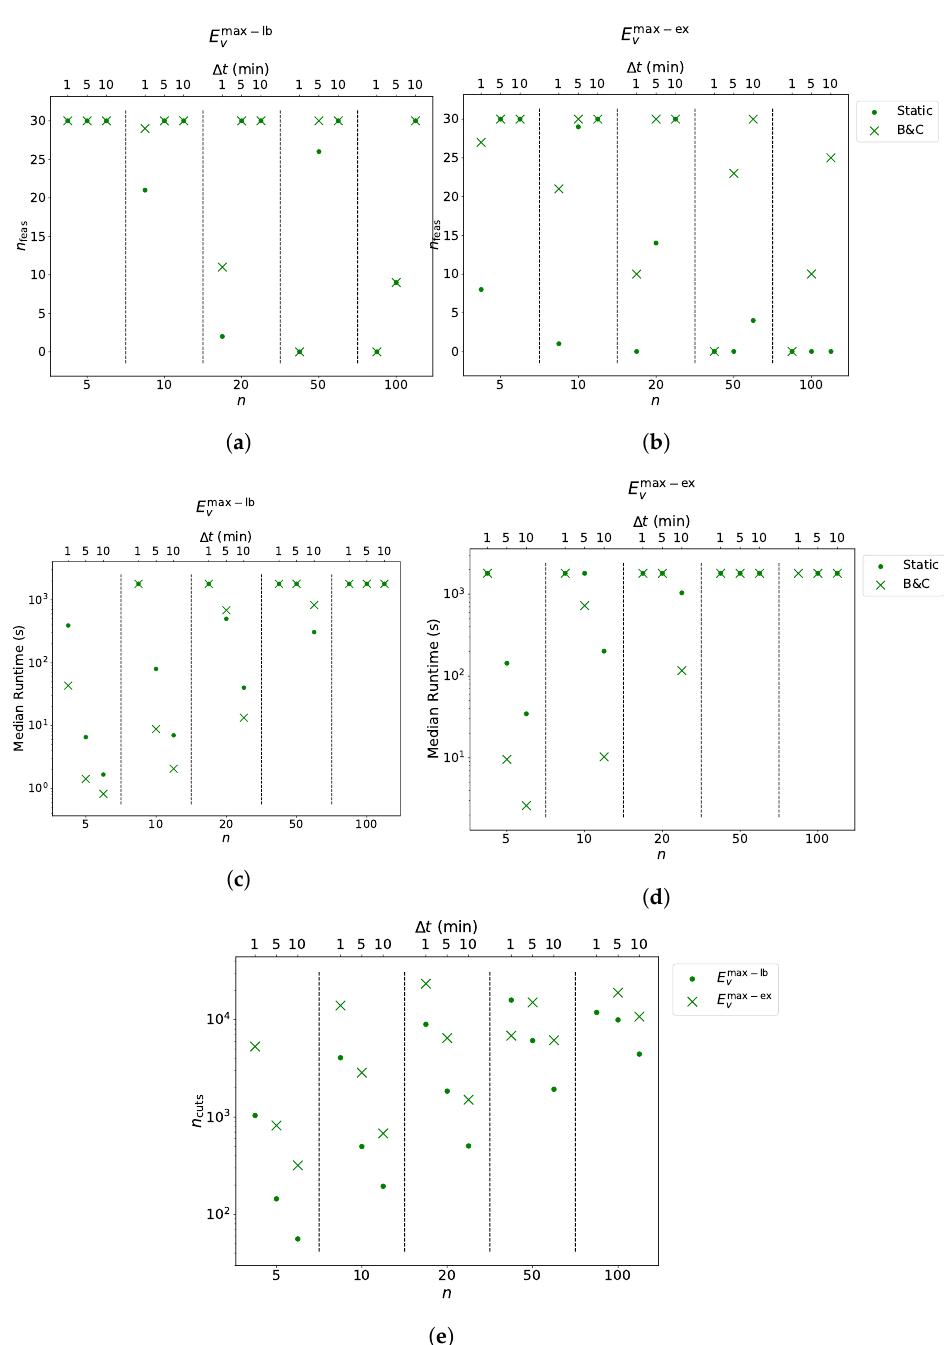
Figure 7. Visualization of EVS-SOC-GLIN results for solving the static model versus B&C with E max-lb v and E max-ex v based on five-segment piecewise linear approximations of the original P max v functions, P gridmax = 10 n . ( a ) Number of feasible solutions found for E max-lb v . ( b ) Number of feasible solutions found for E max-ex v . ( c ) Median runtimes for E max-lb v . ( d ) Median runtimes for E max-ex v . ( e ) Median number of cuts added within B&C for E max-lb v as well as E max-ex v